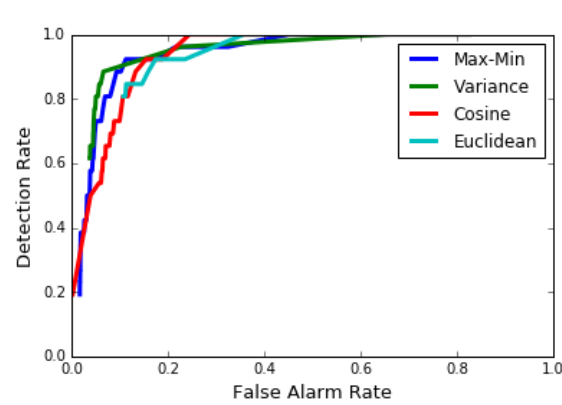
Figure 20. ROC curve of different detector on PU anomaly.